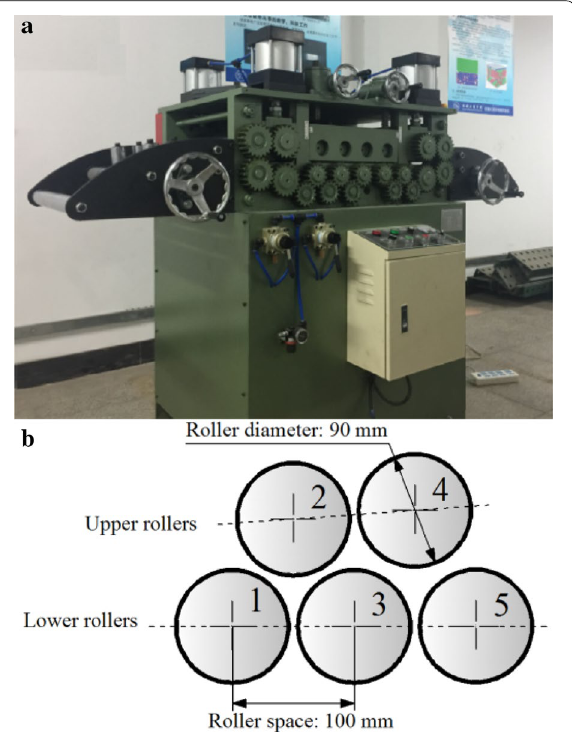
Figure 7 Experimental leveling machine: ( a ) Leveling machine; ( b ) Roller arrangement